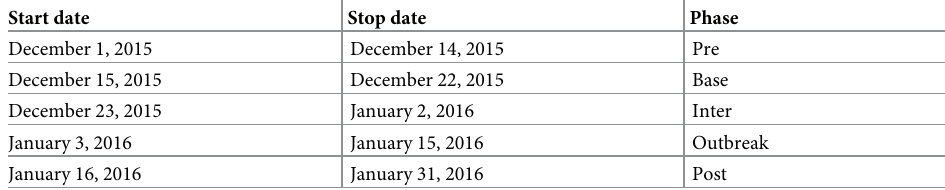
Table 1. Time periods used to study changes in food intake and milk production during a BRSV outbreak.